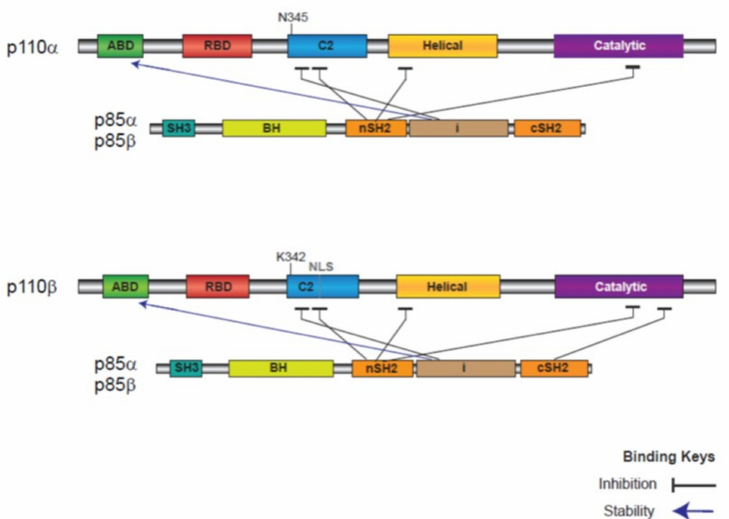
Figure 3. Domain structure of class IA PI3K catalytic and regulatory subunits. Domain structure and interaction of the catalytic subunits p110 α and p110 β and regulatory subunits p85 α and p85 β . The regulatory p85 subunit binds to p110 to inhibit and stabilise the lipid kinase. The interlinker domain of p85 binds to the ABD domain of the p110 subunit to stabilise the kinase (shown with an arrow). On the other hand, the nSH2 and interlinker domains in p85 have an inhibitory effect on both p110 α and β . In addition, the p110 β isoform can be inhibited by the cSH2 domain of p85. The figure is adapted from Reference [18]. Abbreviations: ABD, adaptor binding domain; RBD, Ras-binding domain, C2; protein-kinase-C-homology-2 domain, Helical; helical domain, Catalytic; kinase domain; NLS, nuclear localisation sequence; SH, Src homology; BH, breakpoint-cluster region homology; nSH2, N-terminal SH2; cSH2, C-terminal SH2, i, interlinker SH2 coiled-coiled